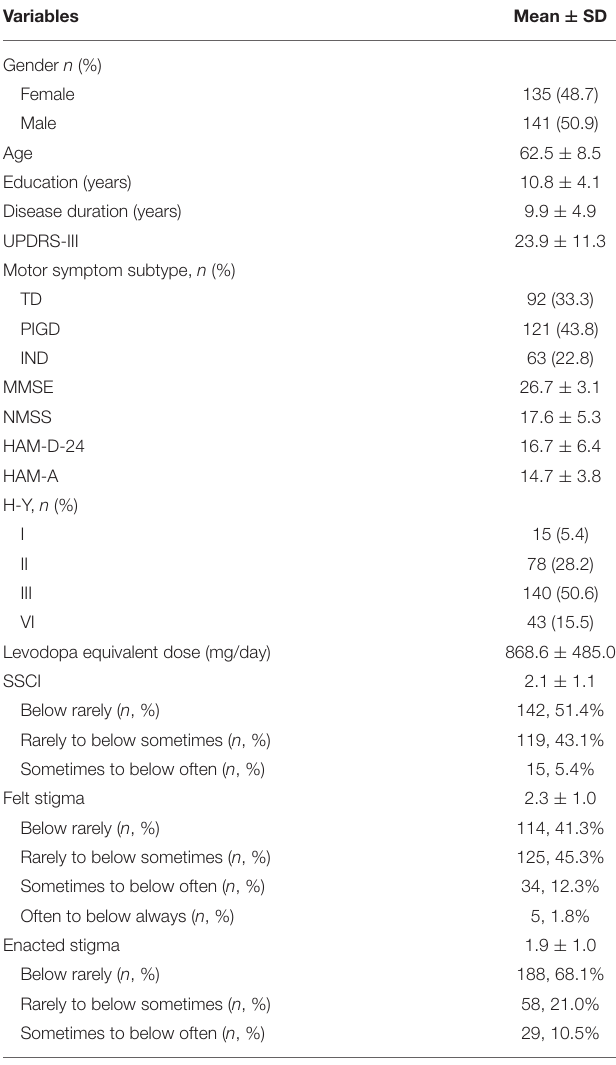
TABLE 1 | General characteristics of PD